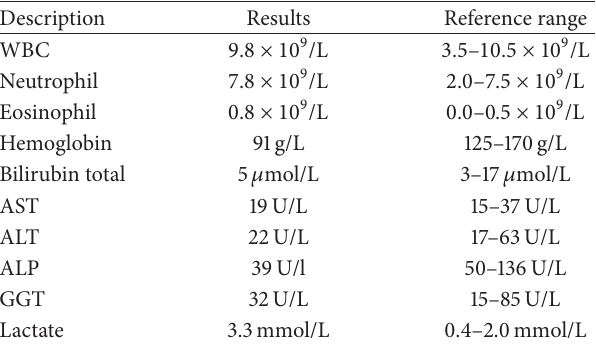
Table 1: Initial laboratory investigations.